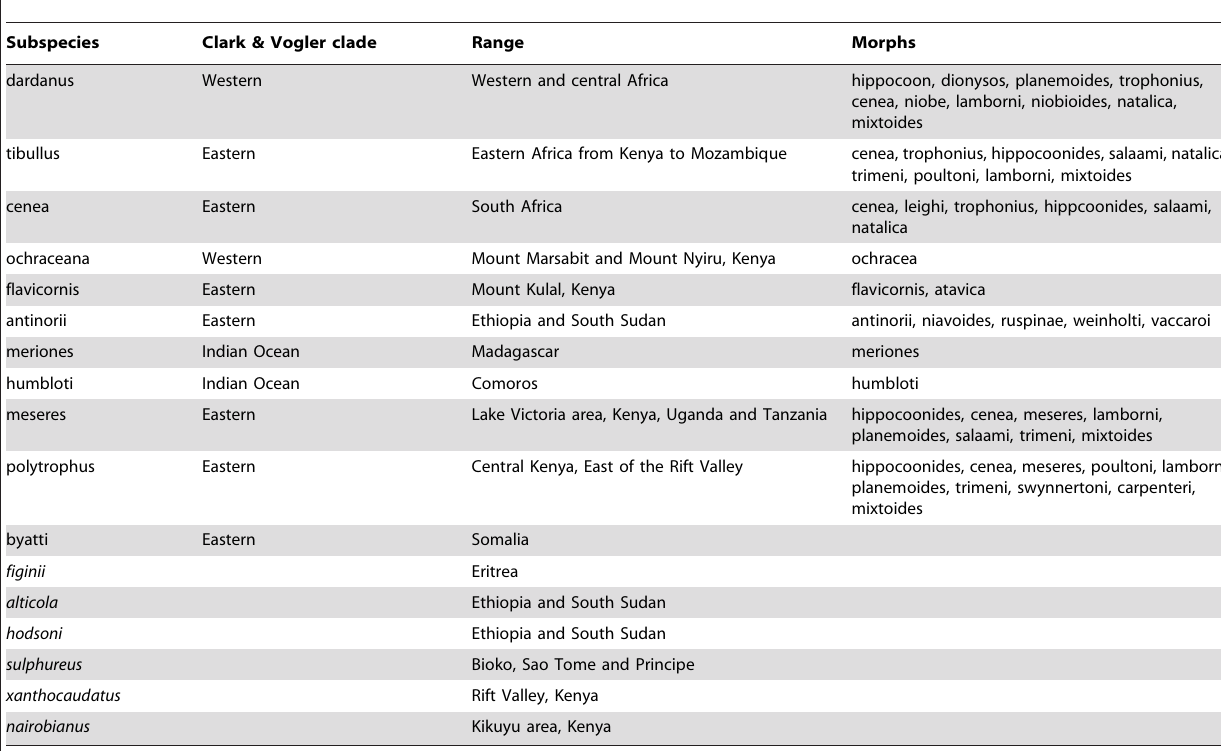
Table 1. List of subspecies, morph groups and ranges, summarised from Bernardi et al.